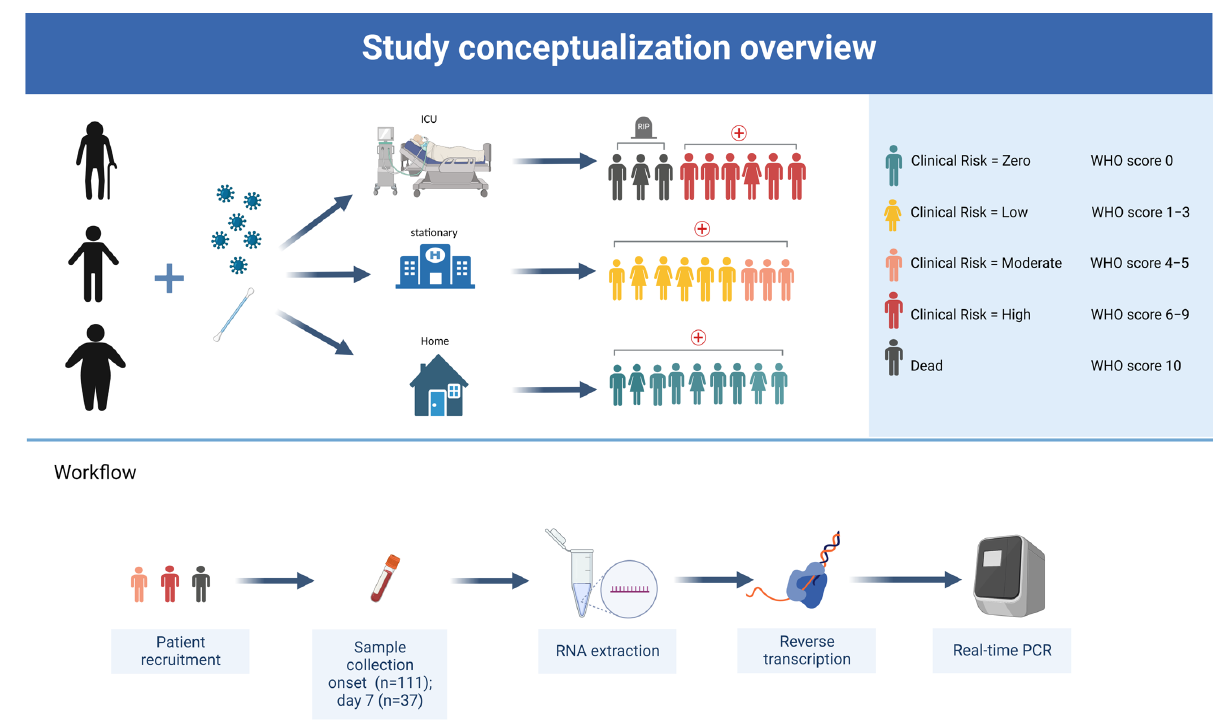
Figure 1. Study conceptualization overview. COVID ‐ 19 positive tested, hospitalized patients were included in the study irrespective of their age and pre ‐ existing conditions. The clinical progression grade scale provides a measure of illness severity from 0 (not infected) to 10 (dead).